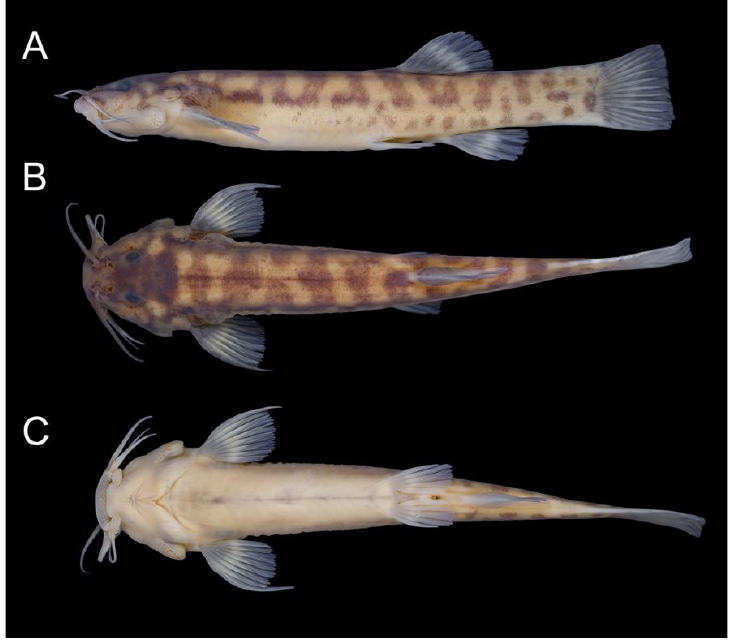
Figure 8. Trichomycterus goeldii , UFRJ 7938, topotype, 57.9 mm SL: ( A ) lateral, ( B ) dorsal, and ( C ) ventral views.